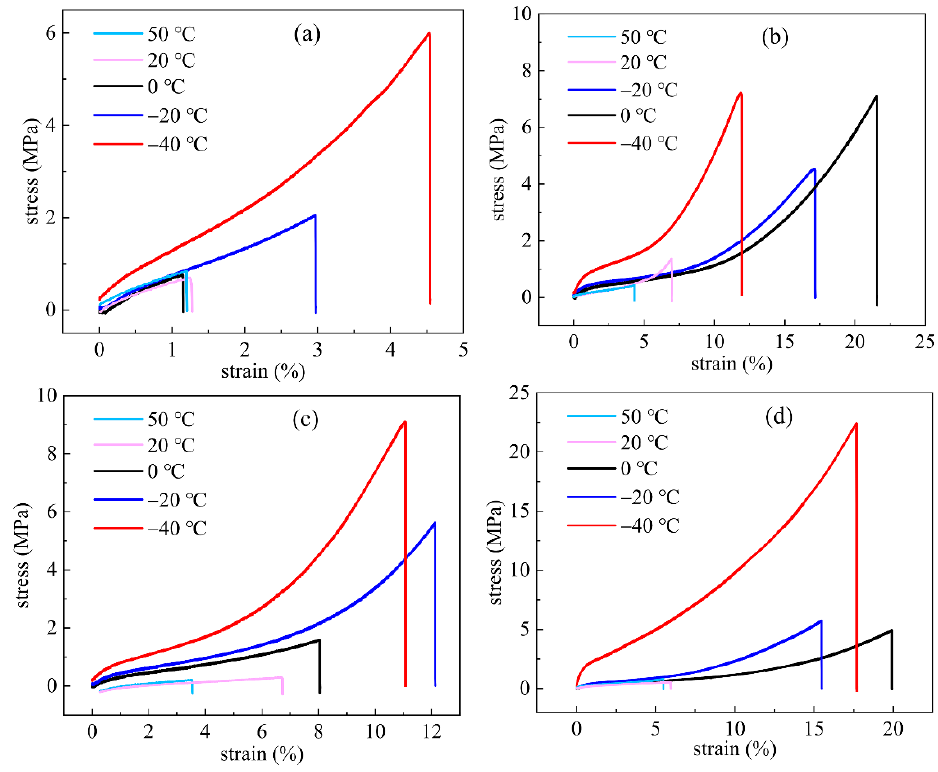
Figure 12. Curves of tensile stress versus strain of IPN binder specimens. ( a ) S-N, ( b ) S-H, ( c ) S-T and ( d ) S-I.